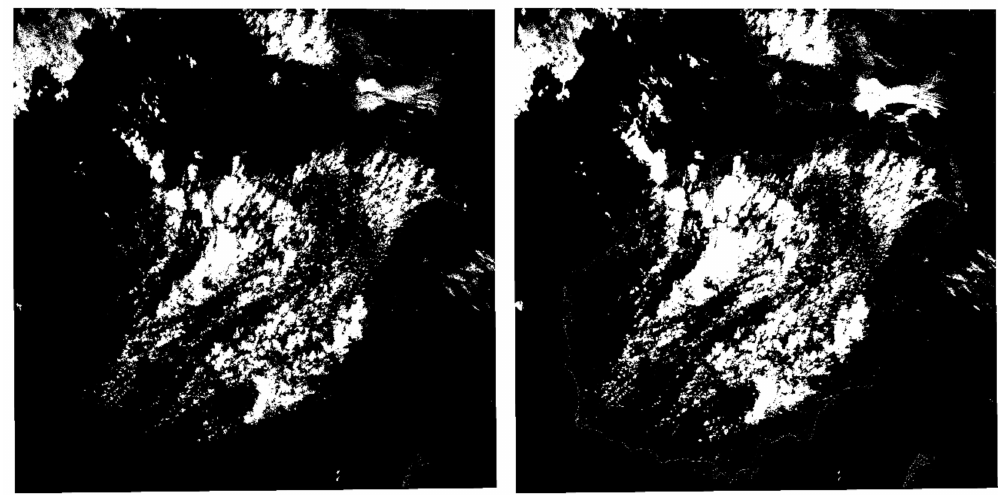
Figure 4. Classification of clouds and background in the Hainan study area using the RTD (left) and Support Vector Machine (SVM; right) methods.